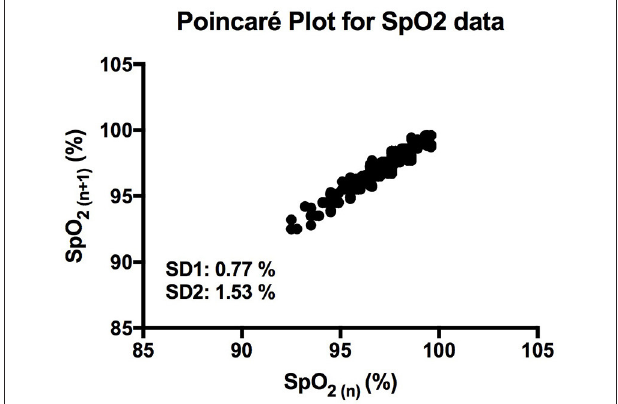
FIGURE 2 | Poincaré plot showing the correlation between consecutive SpO 2 readings in a representative participant. SD1 and SD2 represent the length and width of the plot across the line of